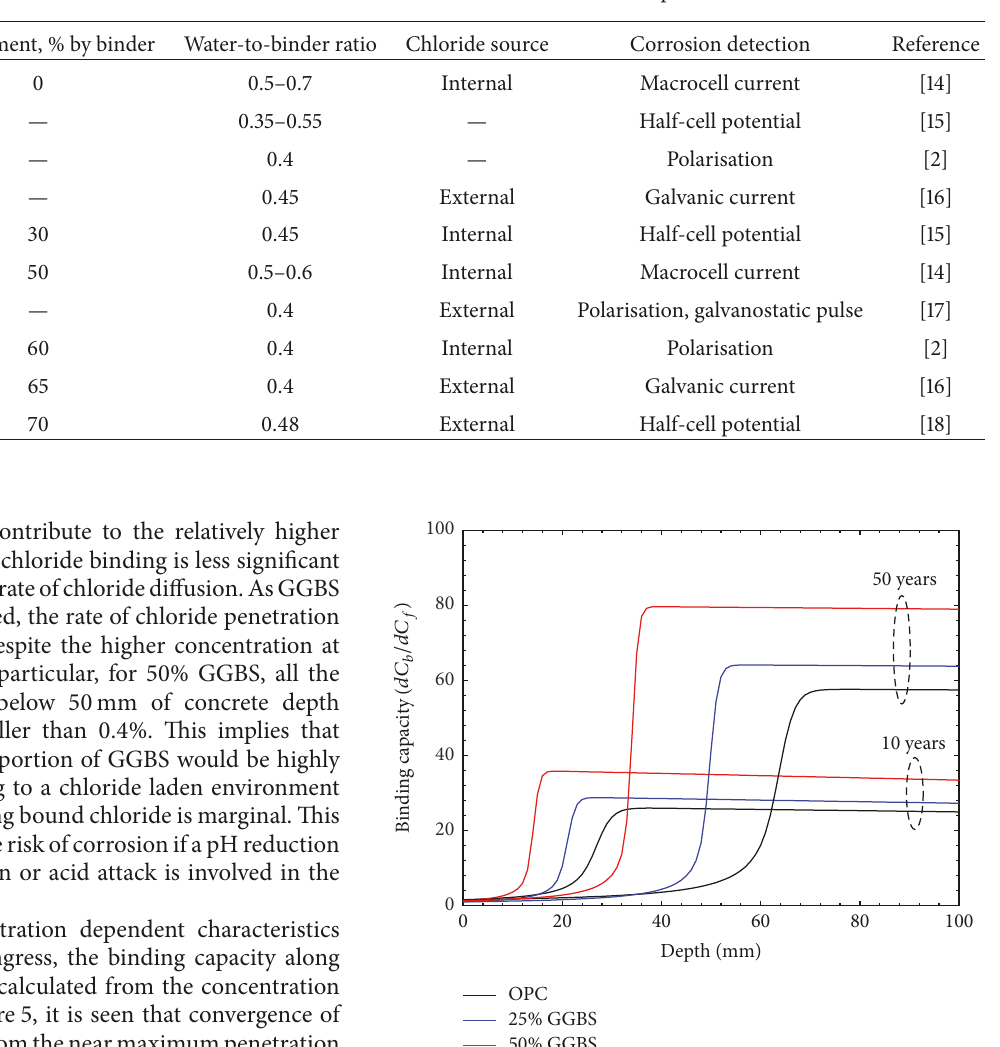
Table 2: Chloride threshold values from literatures with variation of GGBS replacement.